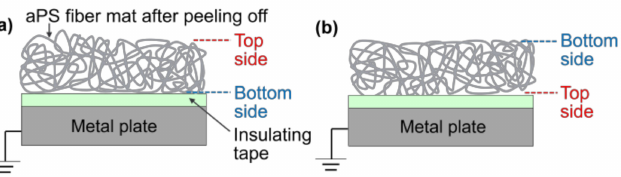
Figure 12. Schematic of the surface potential measurement for the fiber mats after peeling them off and placing them in the ( a ) forward and ( b ) opposite